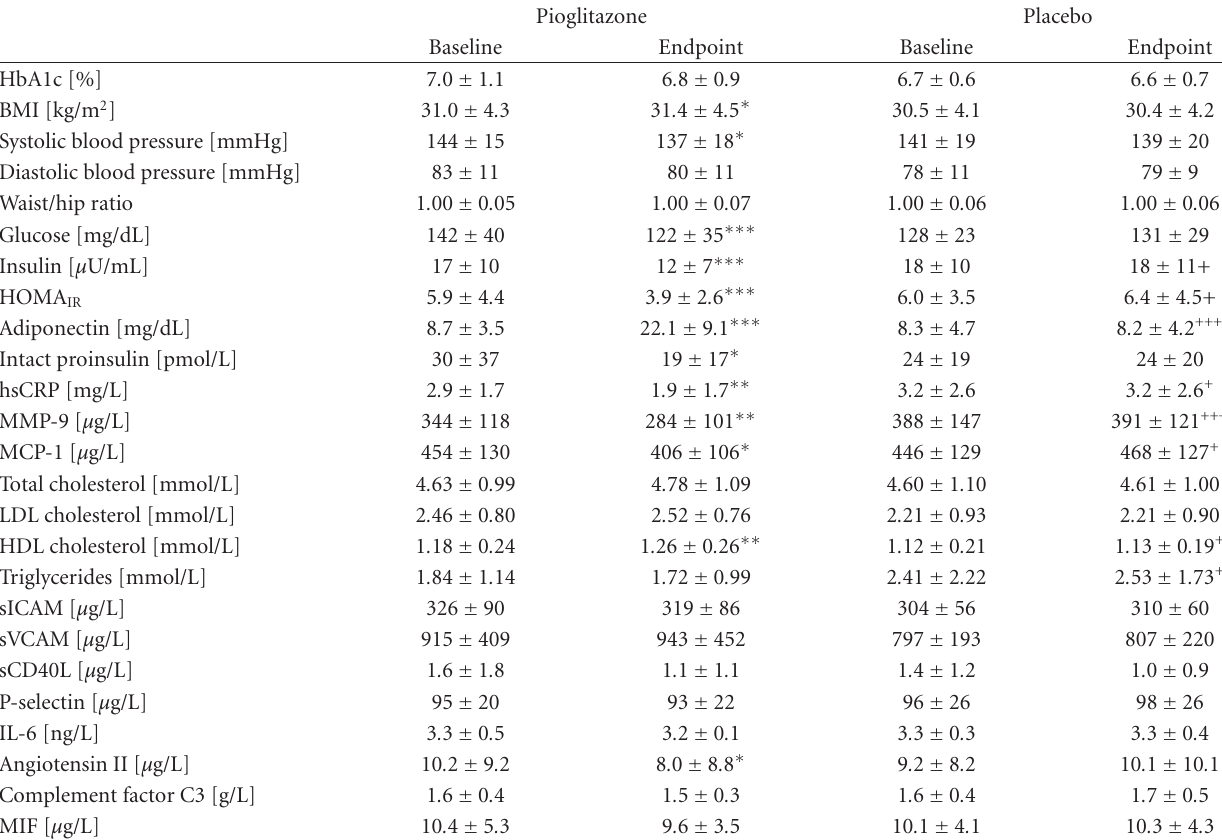
Table 2: Clinical and biochemical observation parameters at baseline and after 4 weeks in both treatment